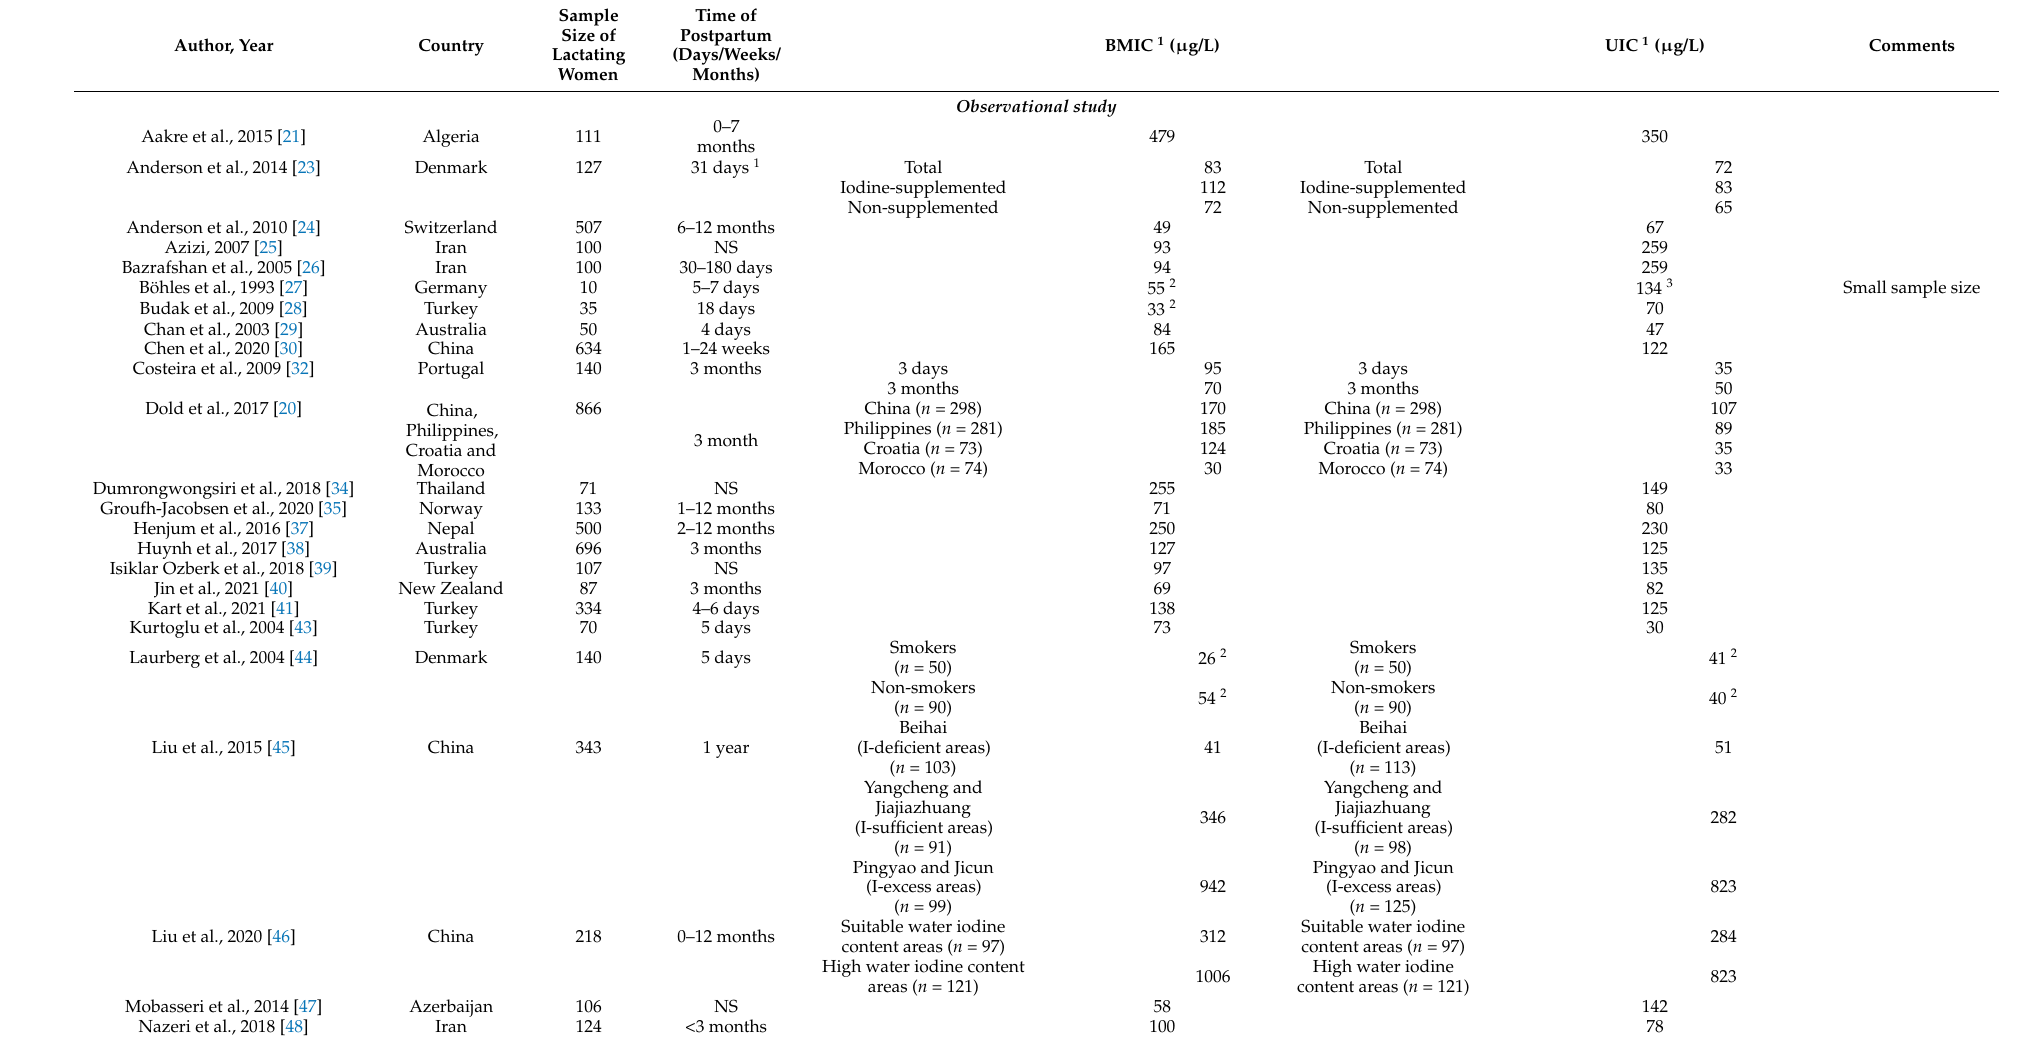
Table 3. BMIC and UIC of lactating